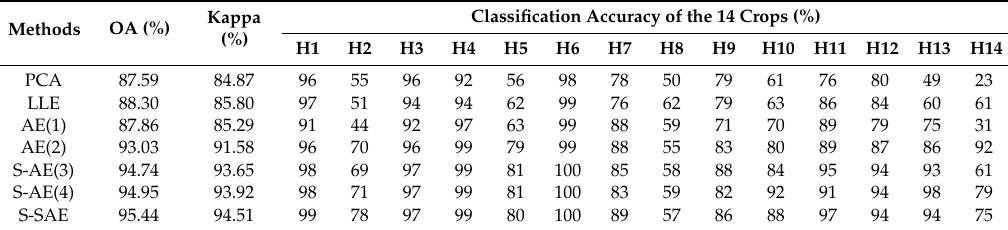
Table 6. Comparison of the CNN classification accuracy with di ff erent dimension reduction methods in Indian Head site.